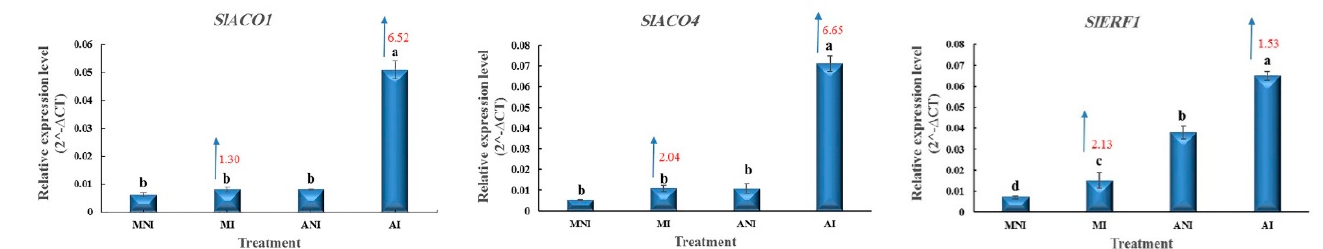
Figure 3. Analysis of the expression levels of ethylene-related genes in the roots of Dutch Mobil and ALYSTE F-1 (as highly susceptible and moderately resistant tomato cultivars, respectively) at 14 days after inoculation with Meloidogyne javanica . Gene expression was measured using quantitative real-time PCR (qRT-PCR). Five biological replicates for each treatment were considered in an experiment, and each biological replicate contained three technical replicates. The experiment was performed three times independently. Tubulin alpha-3 chain ( TAC ) was used as a reference gene for the normalization of qRT-PCR data. The transcript levels were calculated according to the 2 −∆ CT method. The bars represent means 2 −∆ CT ± SE. The numbers displayed in the graph (in red) with blue arrows indicate the fold change (increase or decrease in the expression of genes of each cultivar compared to the corresponding control based on 2 −∆∆ CT ). The means with different letters within each column are significantly ( p ≤ 5%) different according to the Fisher’s least significant difference (LSD) test.